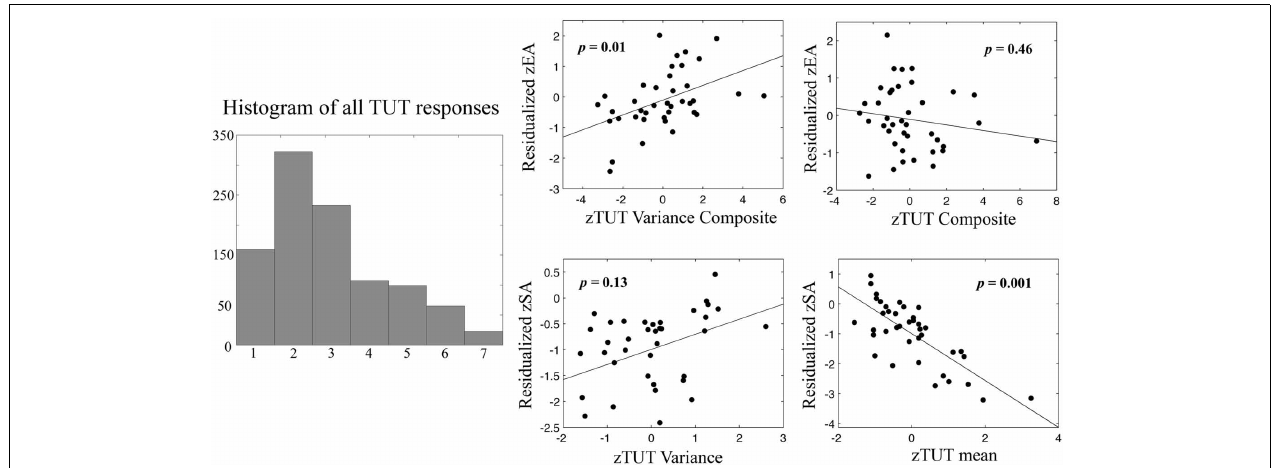
FIGURE 2 | Regression plots of TUT mean TUT Variance vs. error awareness (EA) and stop accuracy (SA). On the left , a histogram of all TUT responses recorded in the session showing continuous distribution of responses from 1 to 7 (scale response value on x-axis). Plotted relationships show a clear relationship between individual differences in TUT Mean and stop accuracy, such that higher levels of TUT predict worse inhibition performance (bottom right). In contrast high levels of TUT Variance predict increased error monitoring ( top left ). Scatterplots depict relationships between TUT Mean , within-subject standard deviation of TUT (TUT Variance ), or